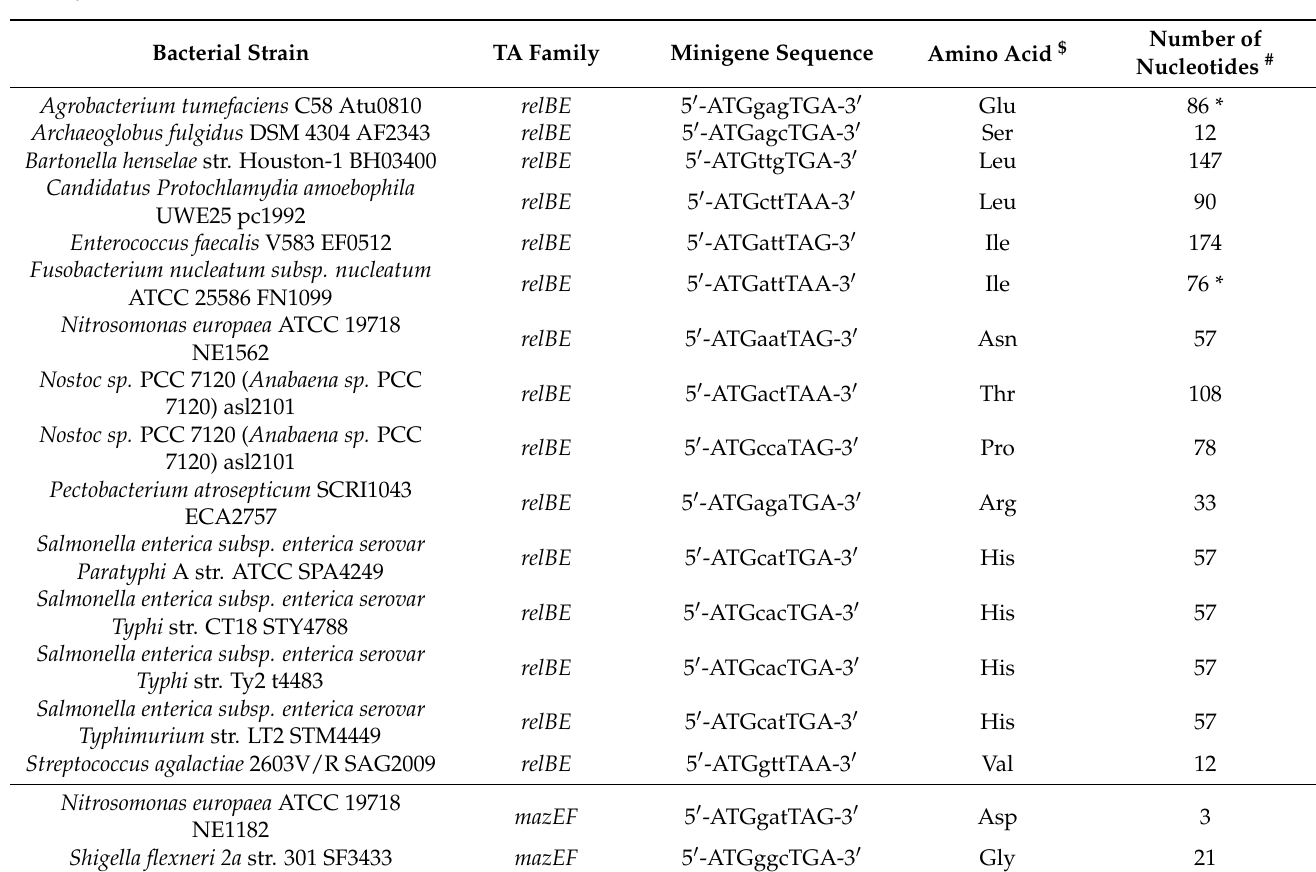
Table 1. A list of 17 bacterial strains where two-ORF minigenes were identified in their antitoxin DNA sequences. The start codon of a minigene is in the same open reading frame as the start codon of a toxin, with two exceptions indicated by